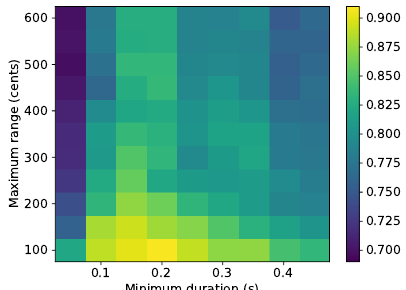
Figure 7. Speech/singing classification F-score for continuous f 0